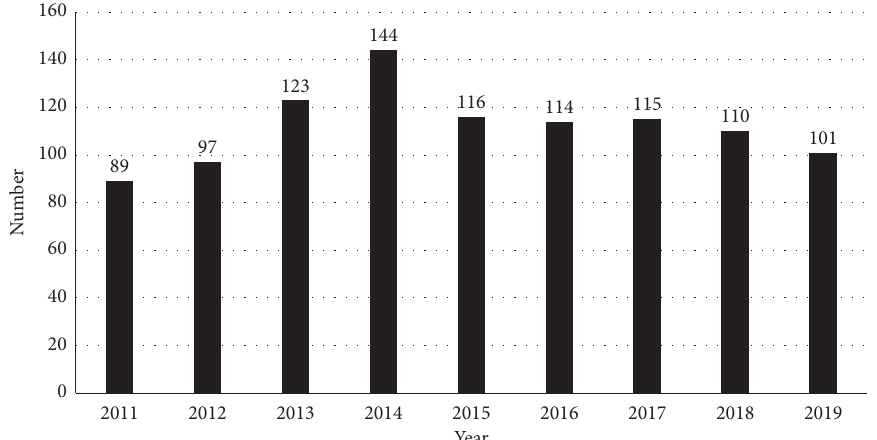
Figure 1: Number of sports industry development projects supported by special funds in Jiangsu province from 2011 to 2019.